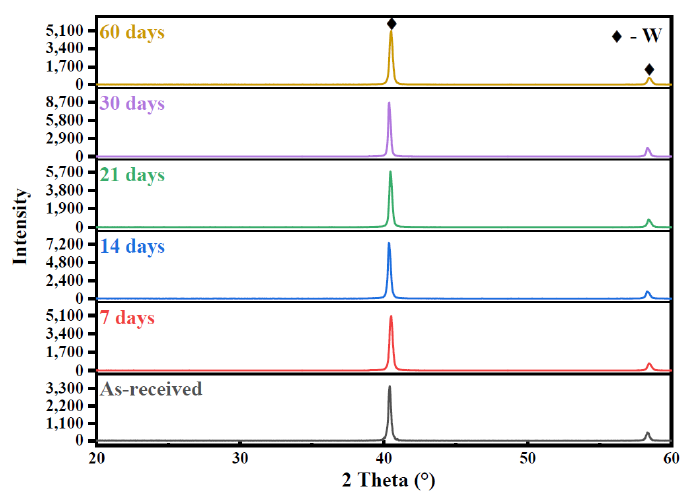
Figure 2. XRD patterns of as-received tungsten and corrosive tungsten in ultrapure water for 7, 14, 21, 30 and 60 days. ◆ is the sign representing a peak belong to tungsten (W).